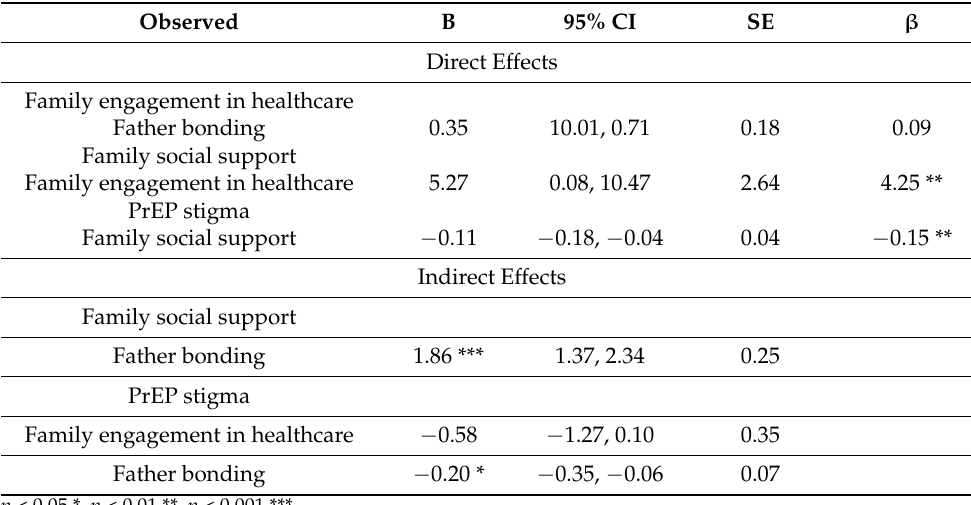
Table 4. Path Analysis Father Bonding on PrEP Stigma ( n =